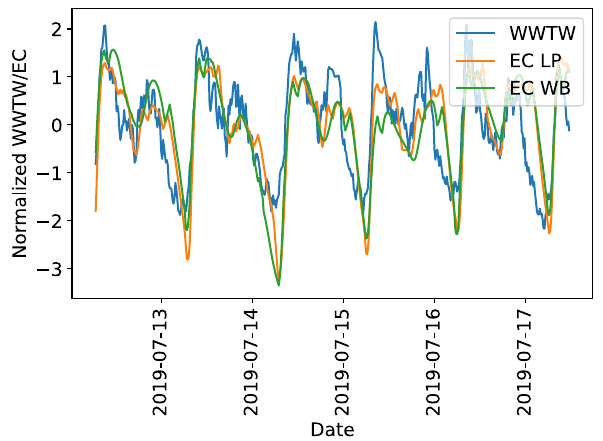
Figure 5. Normalized time series of wastewater treatment works (WWTW) treated effluent discharge and electrical conductivity (EC). EC was measured at LP and WB and shifted by 2.5 and 8.5 hours respectively to account for the time delay of the sewage treatment discharge to reach the sensor site.